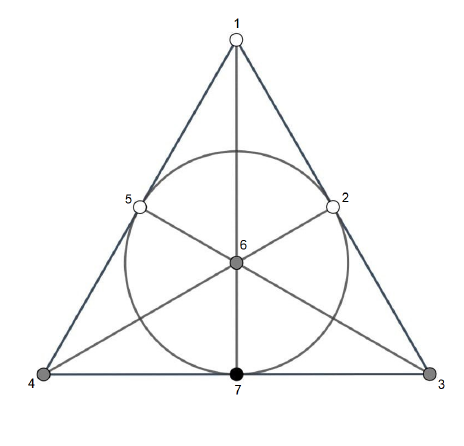
Figure 1. The three colour classes of a STS ( 7 )